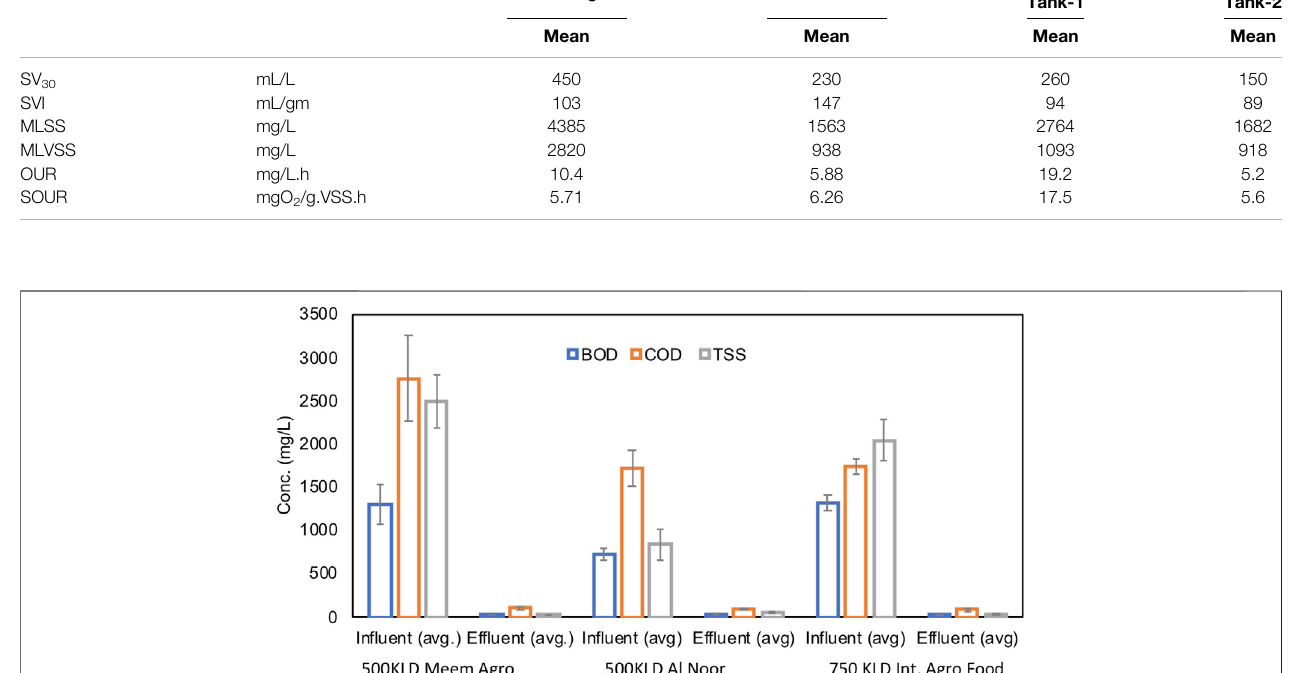
TABLE 5 | Process operational parameter of aeration basin in ETP in three abattoirs. Parameters